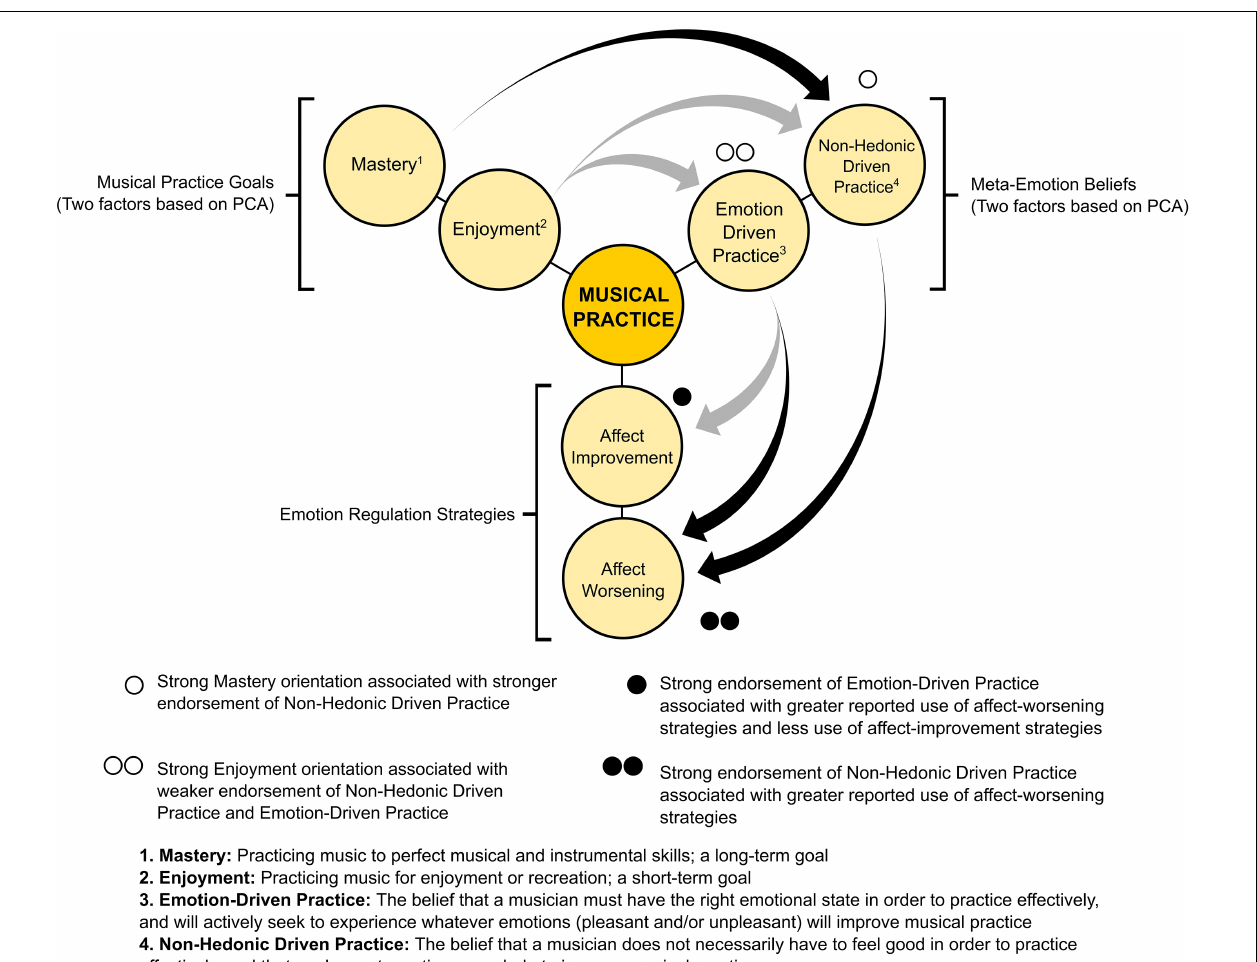
FIGURE 2 | Overview of the main concepts under investigation (practice goals, meta-emotion beliefs, and emotion regulation strategies), and a selection of relevant results. Arrows originate from the independent variables (between-groups factors) to the dependent variables used in MANOVAs (see sections “Emotion Regulation Strategies Used by Musicians Holding Different Meta-Emotion Beliefs’ and “Meta-Emotion Beliefs of Musicians Pursuing Different Goals”). The colour of the arrows indicate the direction of univariate effects (e.g., Black = strong goal orientation associated with stronger belief endorsement; Grey = strong goal orientation associated with weaker belief